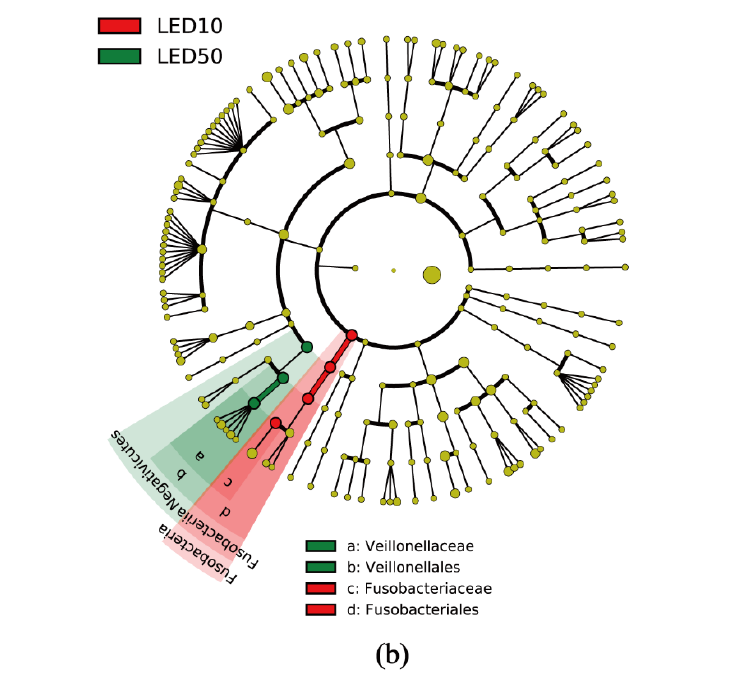
Figure 5. Linear discriminant analysis effect size identification of the most differentially abundant taxa between plaque microbiotas with 10 J/cm 2 and 50 J/cm 2 of violet LED irradiation. ( a ) Histogram of linear discriminant analysis scores (log10) computed for features with differential abundance in samples exposed to 10 J/cm 2 and 50 J/cm 2 of violet LED irradiation (red, 10 J/cm 2 ; green, 50 J/cm 2 ). ( b ) Taxonomic representation of statistically and biologically consistent differences in samples ex- posed to 10 J/cm 2 and 50 J/cm 2 of violet LED irradiation. Each filled circle represents a phylotype. The name of phylum and class are indicated on the cladogram, with the order or family given in the panel below. The diameter of each circle is proportional to the taxon abundance.